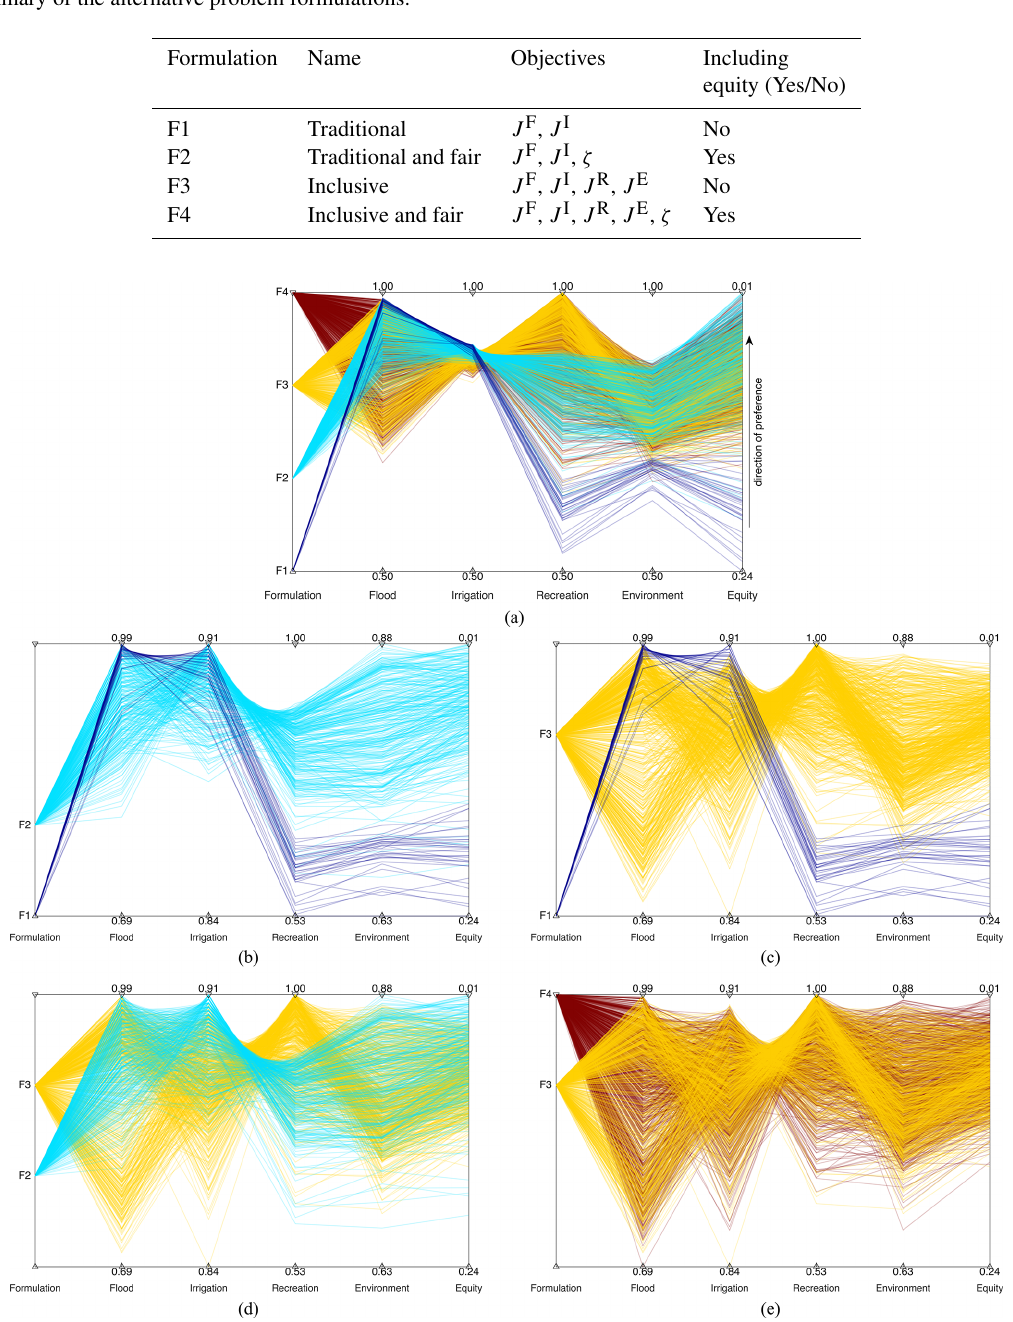
Table 1. Summary of the alternative problem formulations.